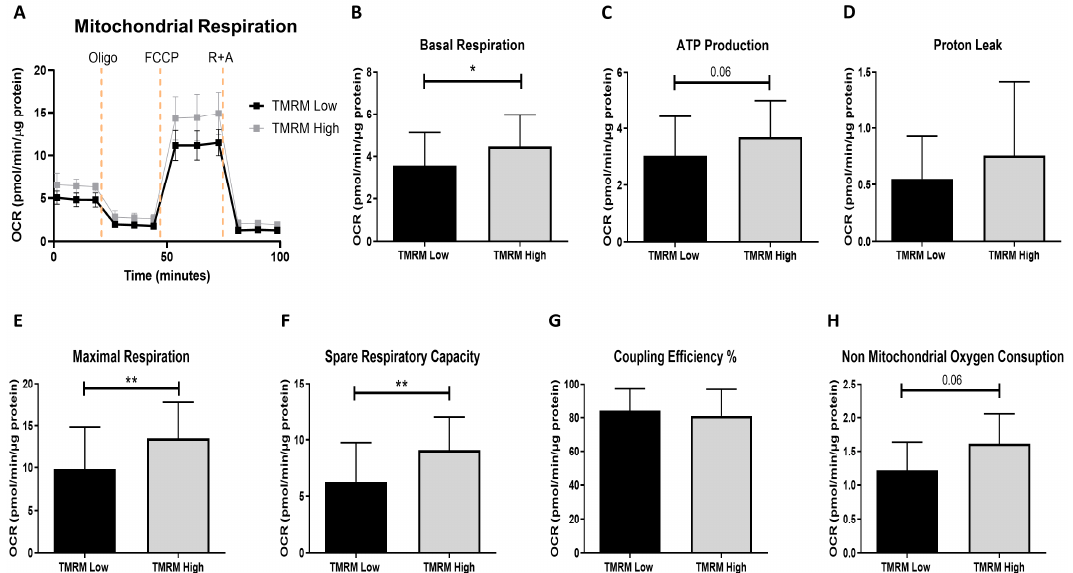
Figure 2. Seahorse extracellular flux analysis for mitochondrial metabolic parameters in